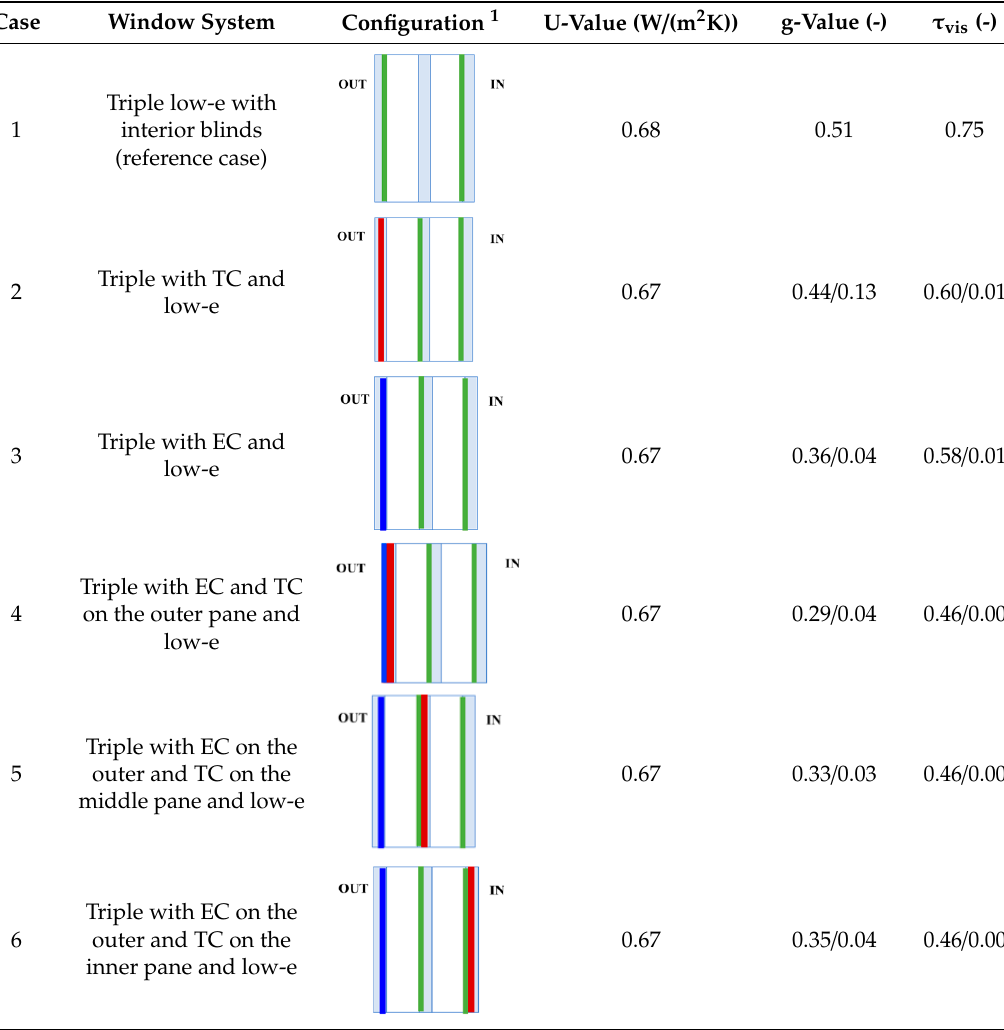
Table 3. Thermal and optical characteristics of the different Insulated Glass Unit (IGU) configurations under investigation.